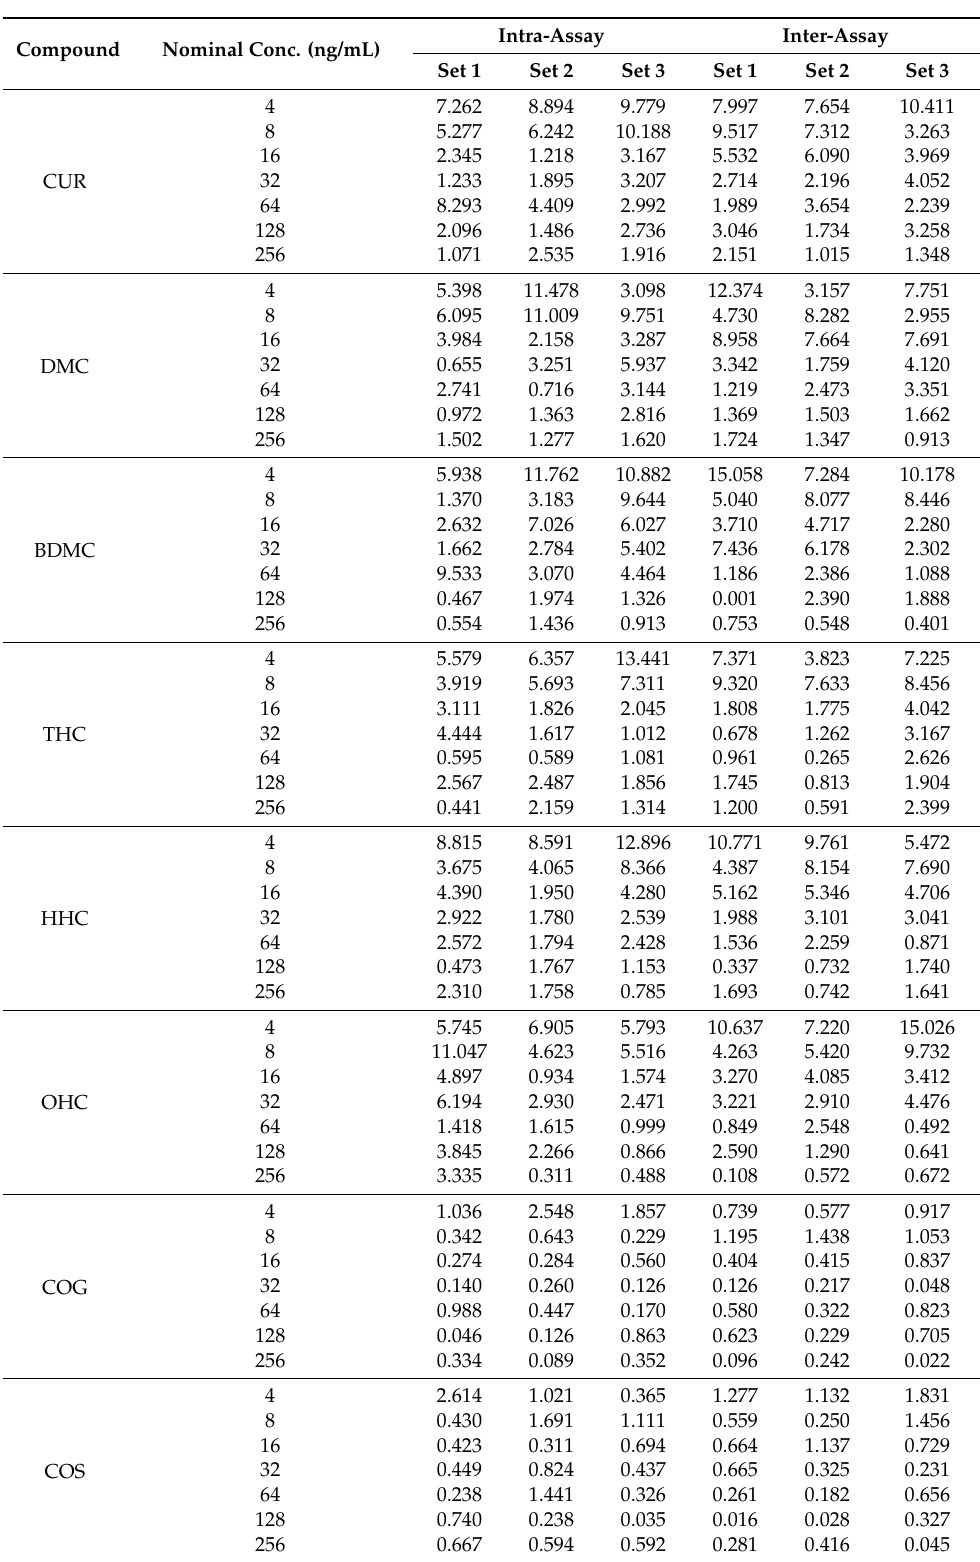
Table 3. Intra and inter day assay precision (% RSD) data for CUR, DMC, BDMC, THC, HHC, OHC, COG and